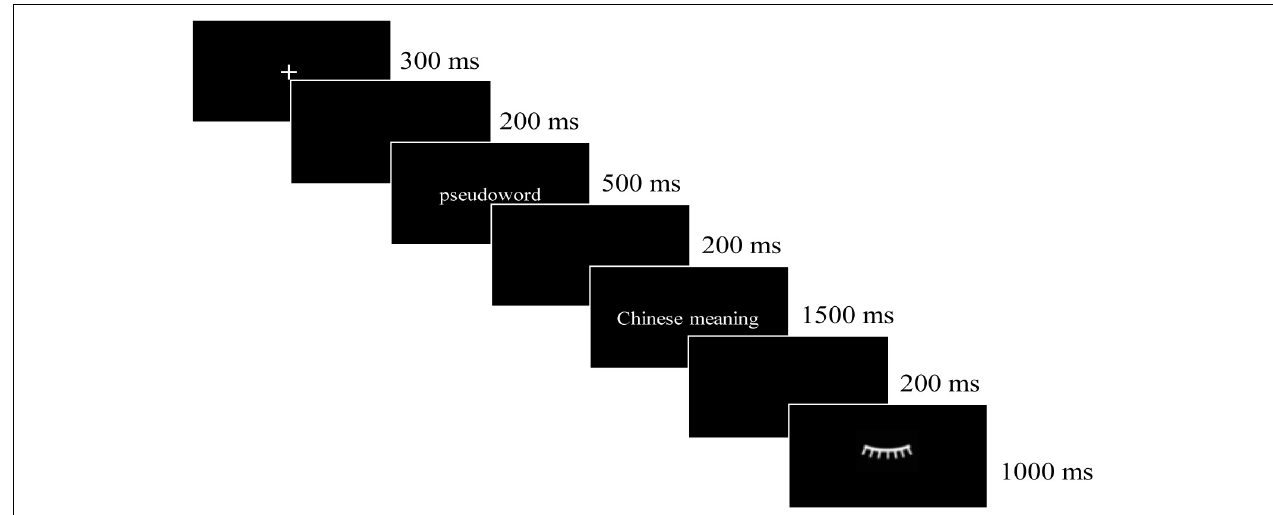
FIGURE 1 | The procedure of